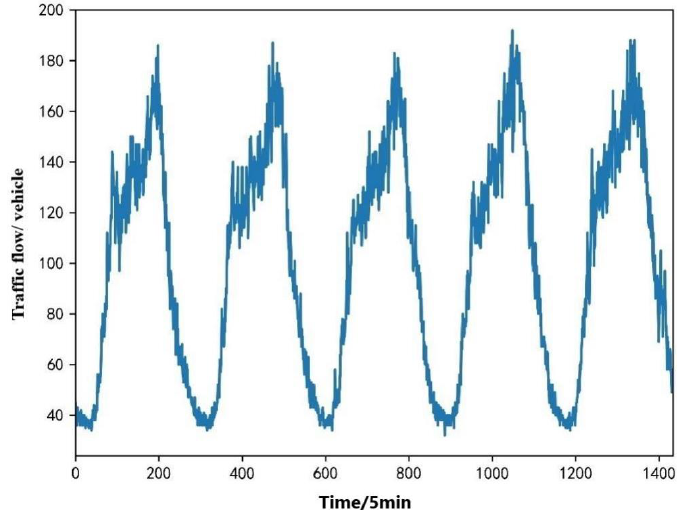
Figure 5. Five-day traffic flow time series curve.